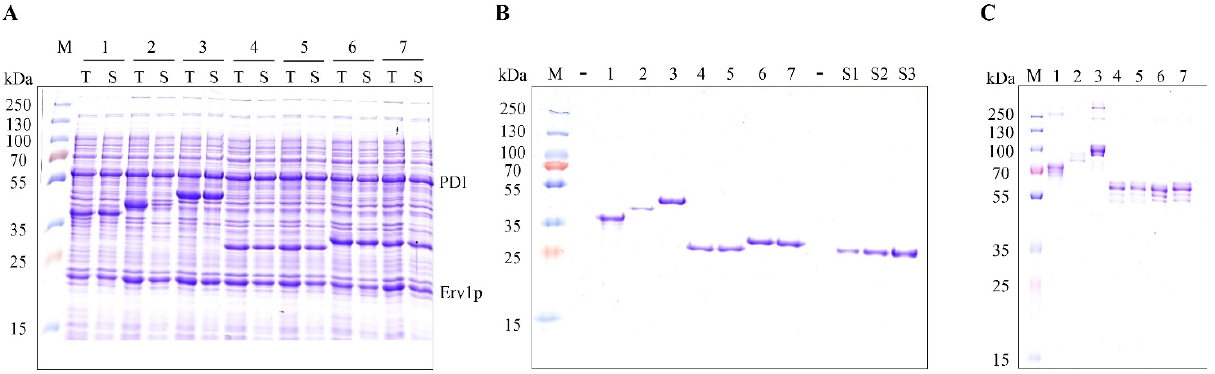
Figure 1. ( A ) Schematic representation of an IgG 1 -based Fc fusion protein. The IgG 1 Fc domain is a natural homodimer consisting of three parts: the hinge region, C H 2 domain and C H 3 domain. Covalent interactions in the hinge region (intermolecular disulfides) as well as non-covalent interactions between the C H 3 domains facilitate the homodimerization of the IgG 1 Fc region. ( B ) Schematic representation of the fusion partners used in the study and their disulfide-bonding patterns (Ang1: Angiopoietin 1, Ang2: Angiopoietin 2). All the Fc fusion proteins used in this study have the partner hormone or peptide fused to the C-terminus of the C H 3 domain.